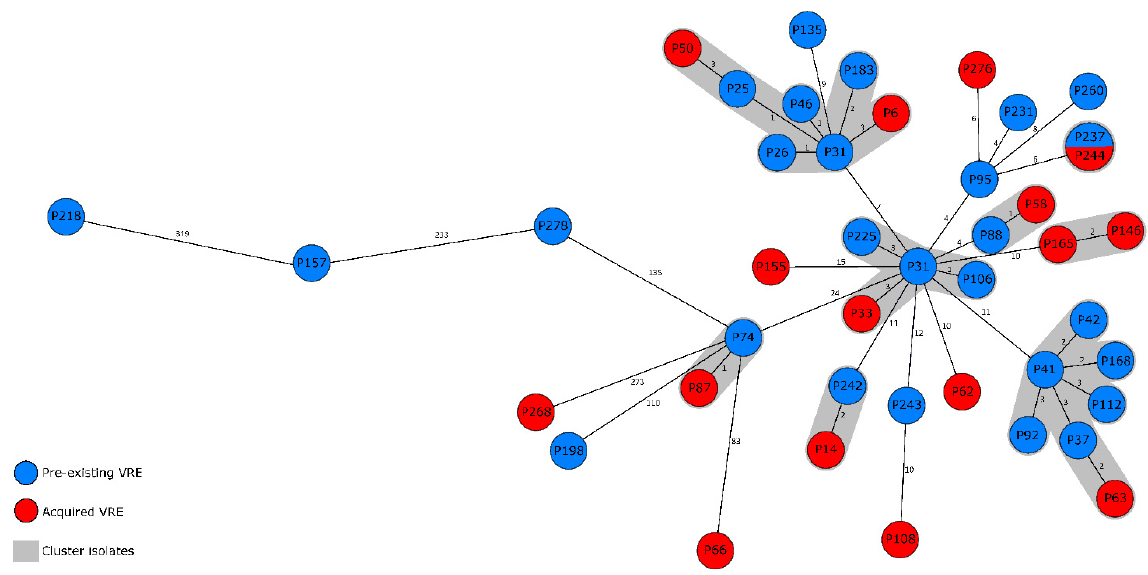
Figure 2. Minimum spanning tree of 43 preexisting ( n = 27, blue) and acquired ( n = 16, red) VRE strains based on 1423 target genes pairwise, ignoring missing values and numbered consecutively. Each circle represents one genotype. Connecting lines between genotypes indicate the number of allelic differences. Grey shadings illustrate close genetic relations ( ≤ 3 alleles difference between directly connected genotypes).